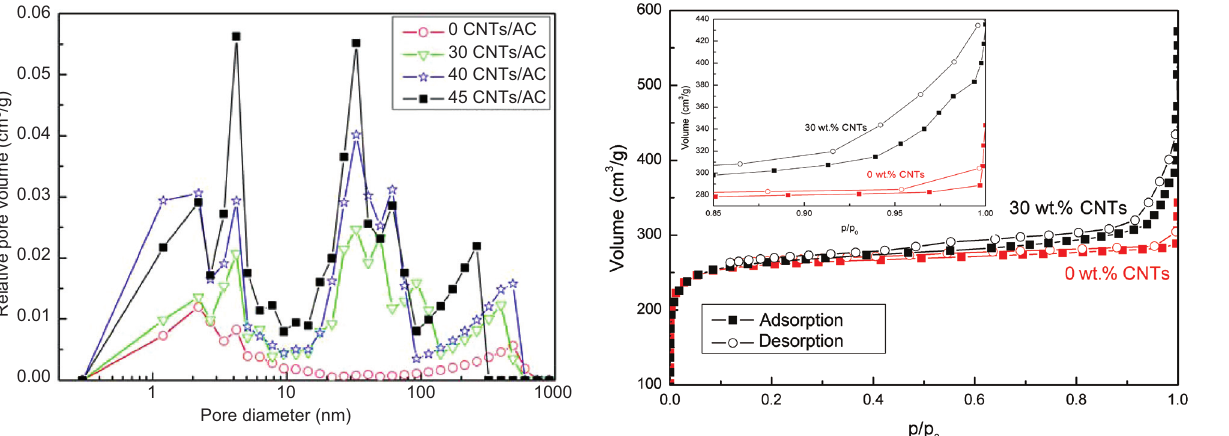
adsorption/desorption isotherms of composite Figure 9 N 2 spheres (activated at 850 ° C for 90 min) at 77